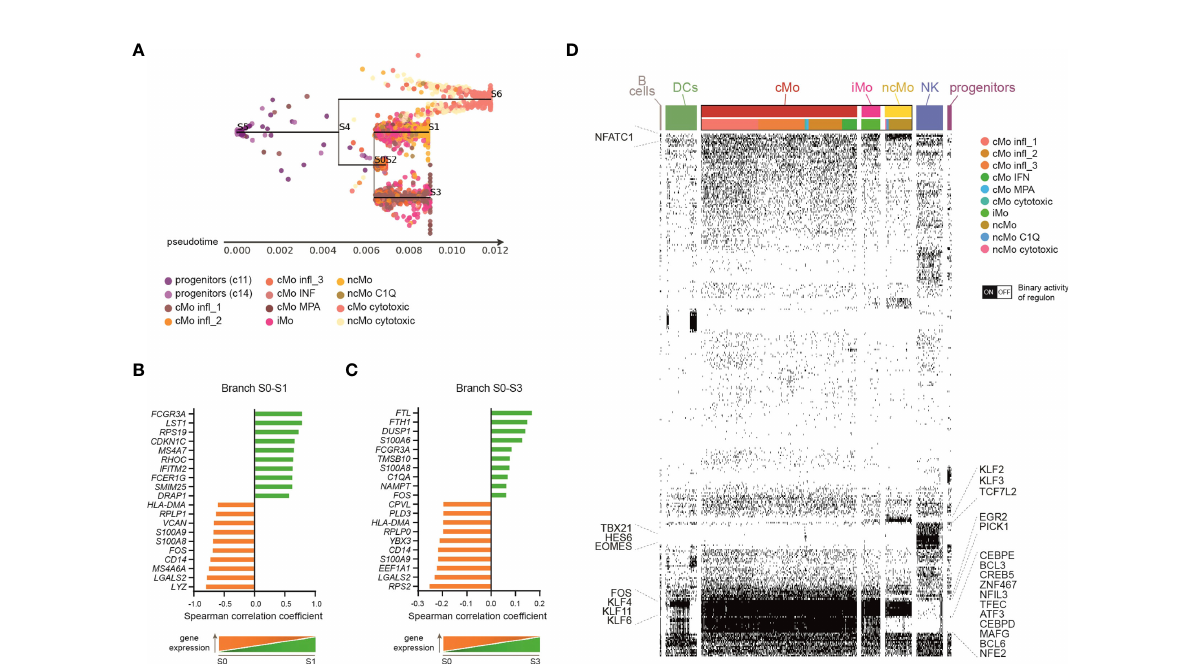
FIGURE 3 Monocyte subsets developmental relationship. (A) Subway map plot visualization of inferred developmental trajectory of myeloid progenitors and monocytes by STREAM. Cells are colored according to the cluster of origin as shown in the legend. Starting from myeloid progenitors, cells bifurcated into Mo cytotoxic (branch S4-S6) and a branch that further separated into three sub-branches: classical monocytes (belonging to c1, c2, c7, c12) primarily localize into node S0 and branch S0-S2; branch S0-S3 is mainly consisted of classical monocytes from c0; branch S0-S1 identify a clear directional progress from the intermediate to the non-classical monocytic cells. (B, C) Bar plots showing the top-20 transition markers signi fi cantly most correlated with the pseudotime calculated in branch S0-S3 (B) , containing classical monocytes from c0, or branch S0-S1 (C) , containing intermediate and non-classical monocytes from c6, c3 and c13. 10 genes positively and 10 genes negatively correlated are shown. (D) Single cell binary matrix showing the activity of each regulon in each cell (black blocks represent cells that are “ on ” , white blocks cells that are “ off ” ). TFs belonging to selected regulons active in monocytes are